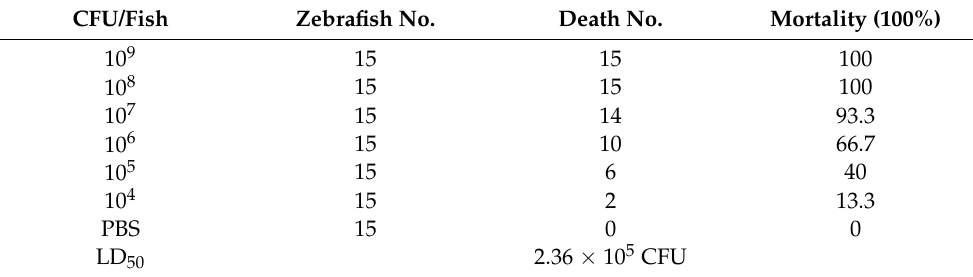
Table 3. LD 50 of the zebrafish after challenged by SS7. CFU/Fish Zebrafish No. Death No.